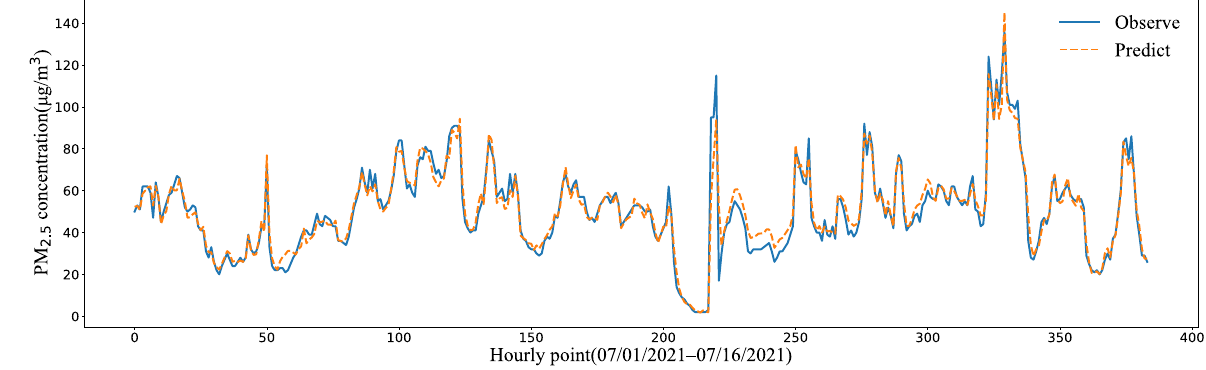
Figure 10. Prediction results for frequent changes in PM2.5.